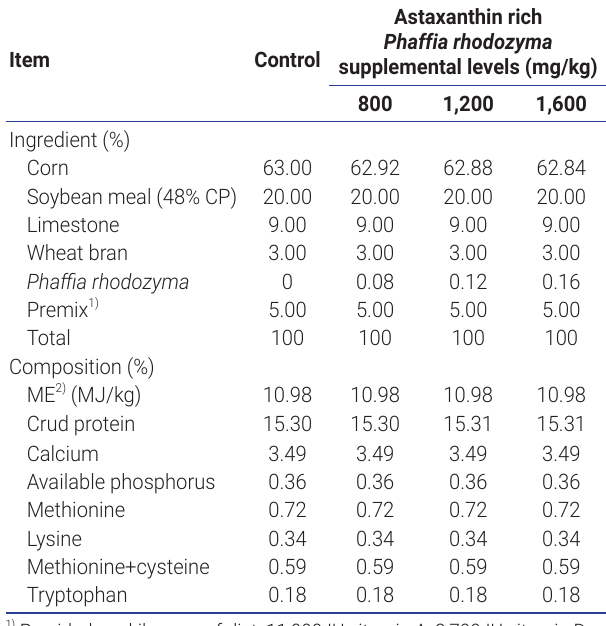
Table 1. Ingredients and diet composition (as-fed